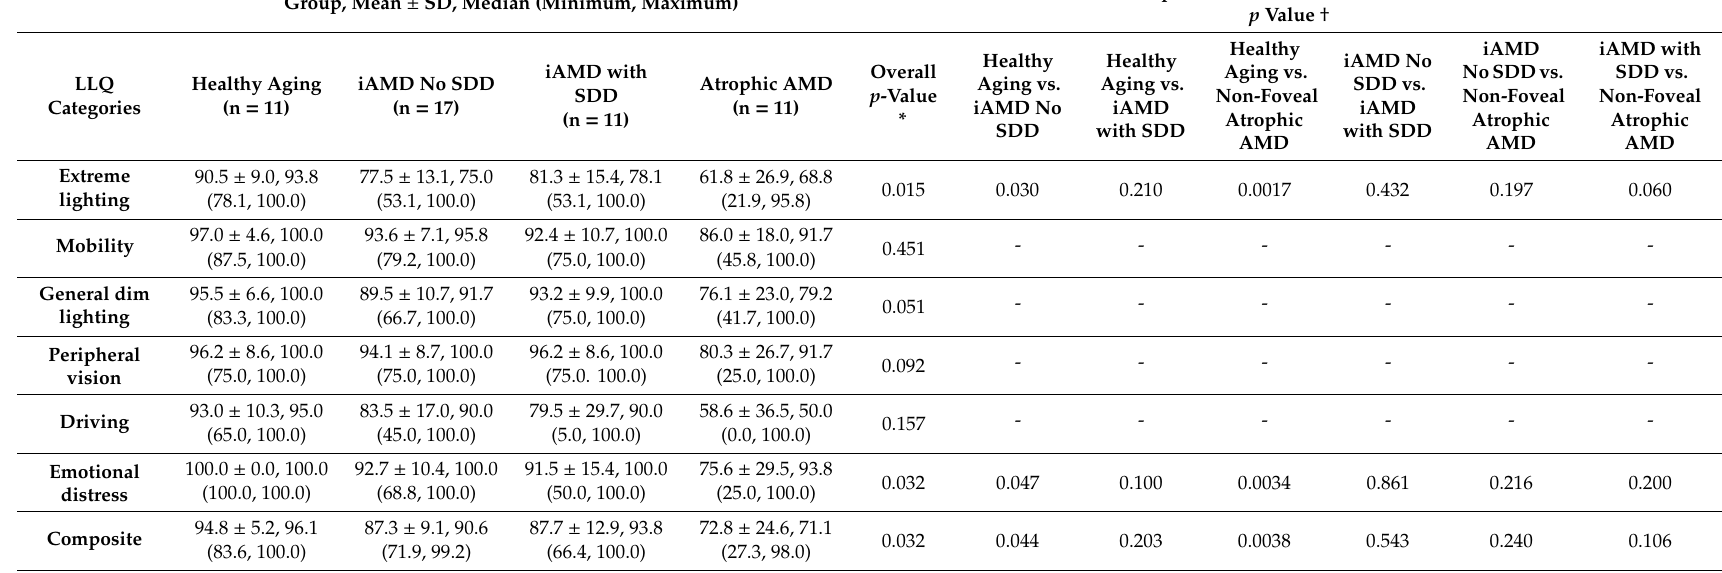
Table 2. The LLQ subscale and composite scores between each subject group.